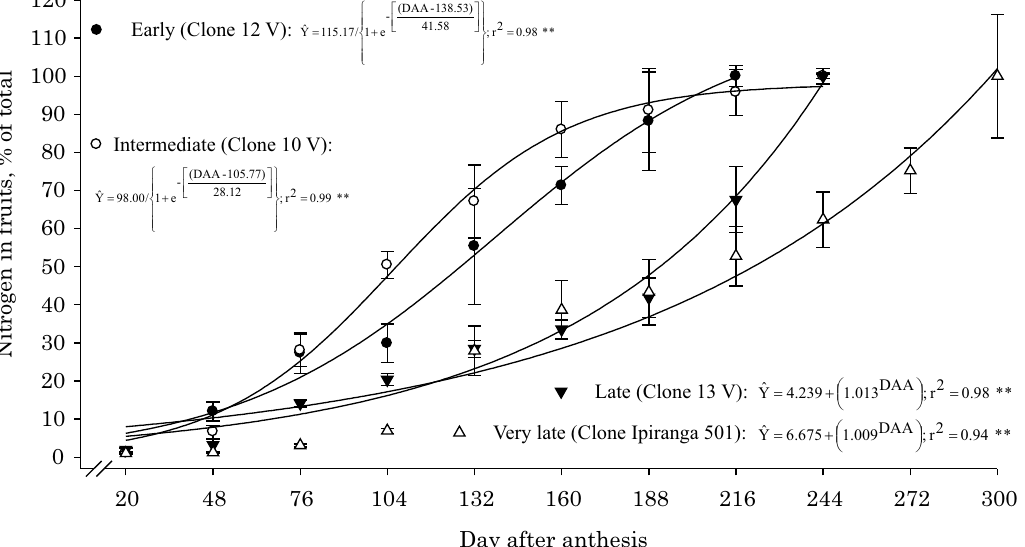
Figure 2. Accumulation of nitrogen in fruits (in percentage of the cumulative total) of four genotypes (clones) of Conilon coffee, from anthesis to fruit maturation. The bars refer to the standard error of the average. ** significant at 1 %